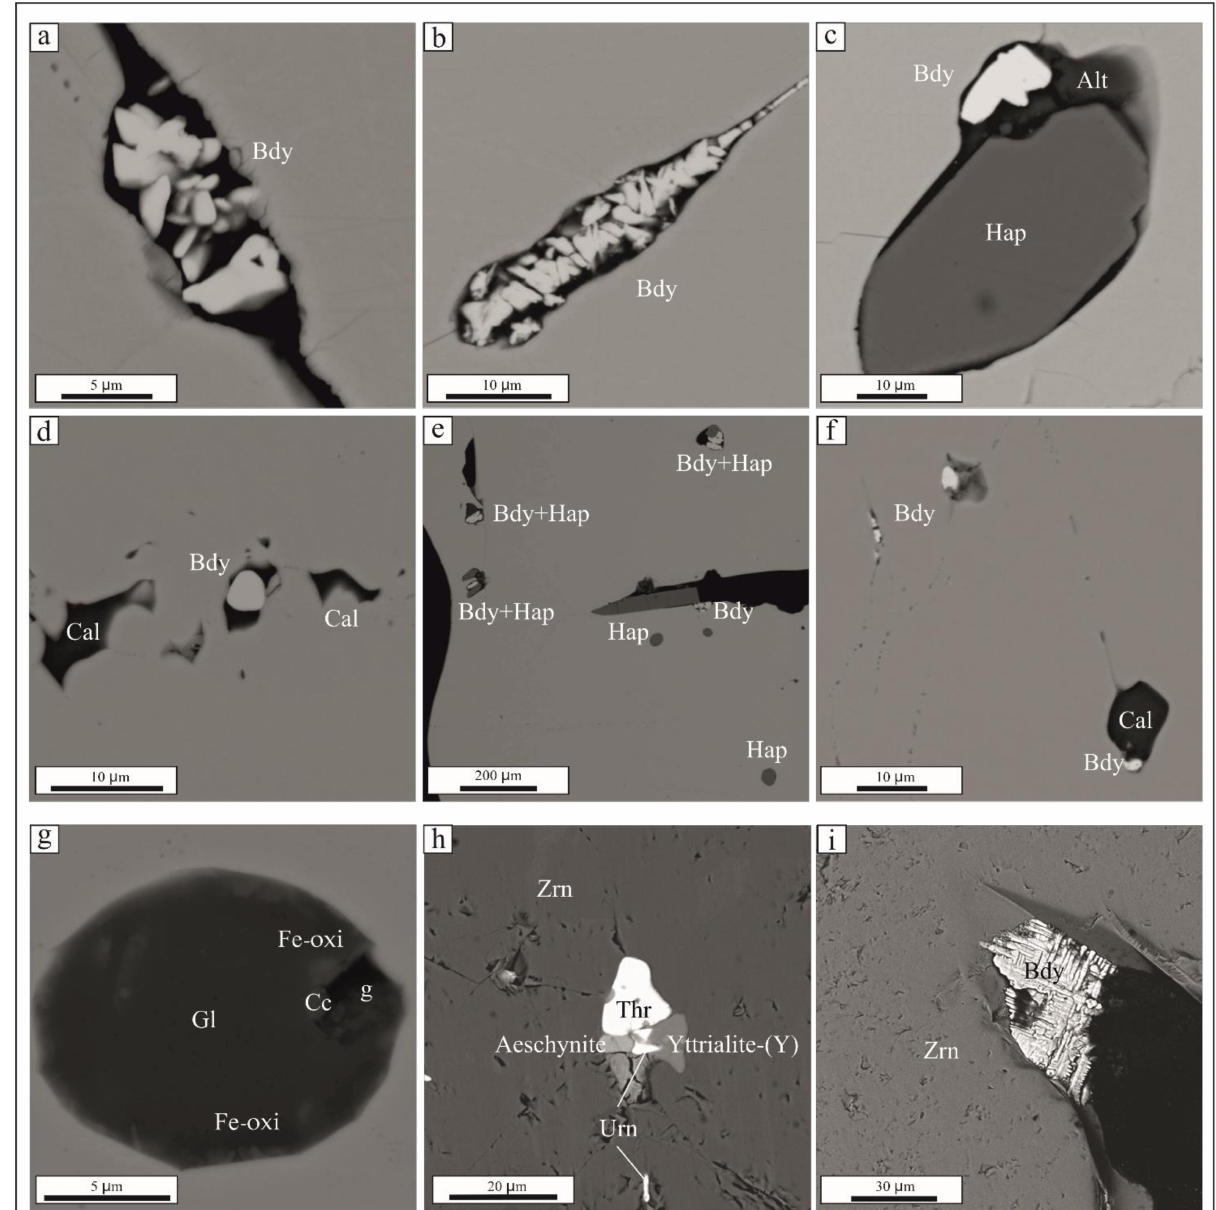
Figure 6. Mono- and poly-mineralic inclusions in the zircons from Le Fosse di Novale, BSE images. ( a ) VR1-3; ( b ) VR1-3-2; ( c ) VR2-1; ( d ) VR2-3-n1; ( e ) VR2-1-n1; ( f ) VR2-2-n2; ( g ) VR2-1; ( h ) aeschynite, yttrialite (Y), uraninite and thorite in zircon; ( i ) baddeleyite in zircon. Symbols: Bdy—baddeleyite, Hap—hydroxylapatite; Cal—calcite; Alt—alteration Al–Si-mineral (chlorite), Zrn—zircon, Thr—thorite,